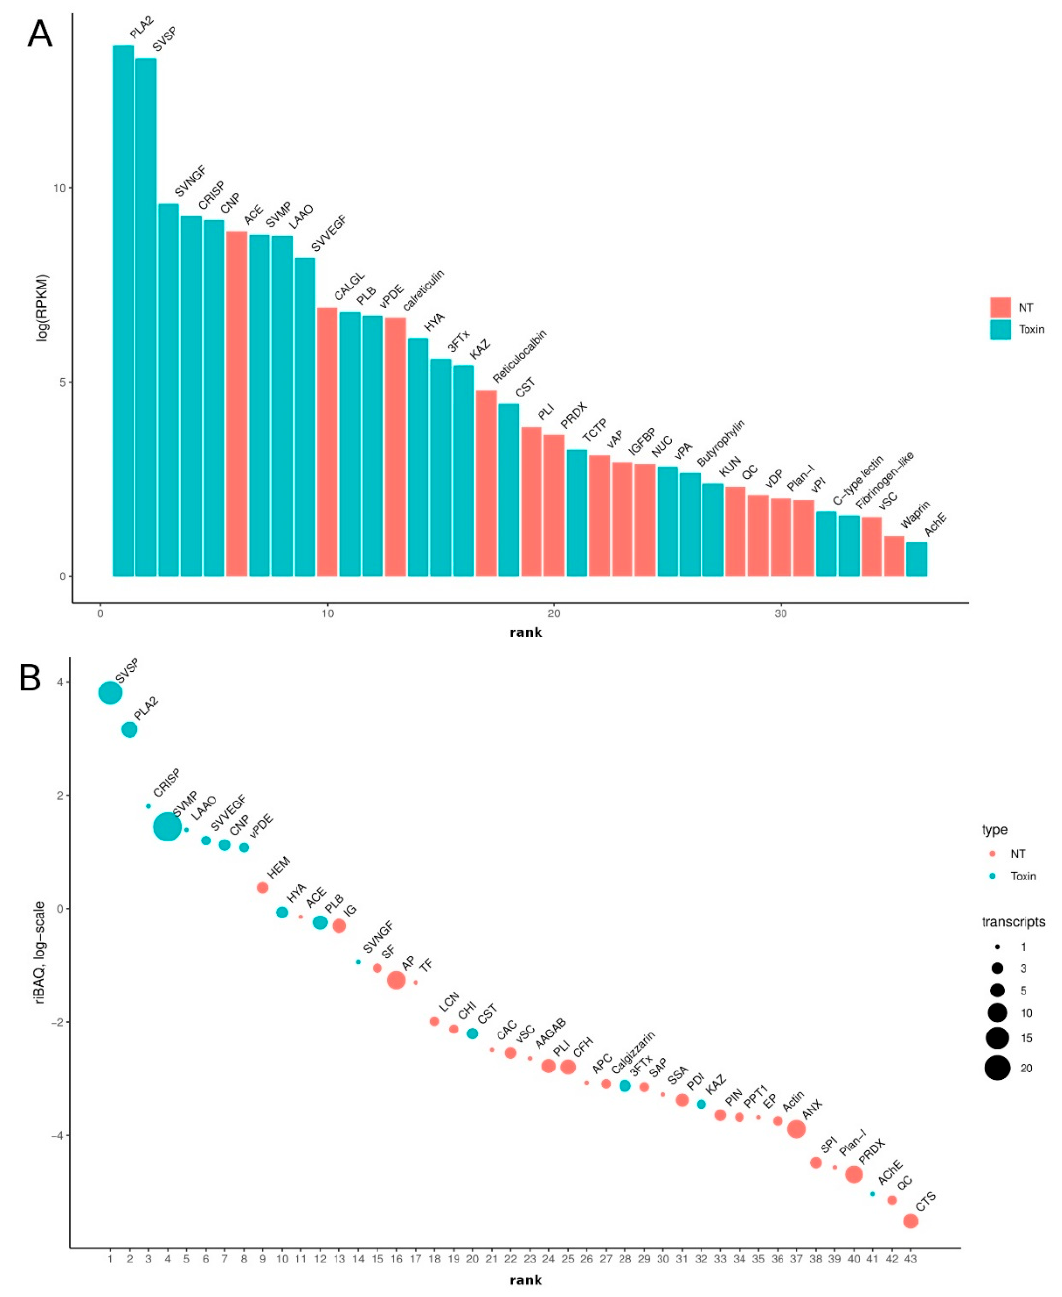
Figure 2. ( A ) Bar chart showing the distribution of Reads Per Kilobase Million (RPKM) values for all putative venom proteins (PVP) families found in transcriptome; ( B ) Scatter plot showing the distribution of riBAQ values of top 43 protein families. The diameter of the circle is proportional to the number of identified transcripts by quantitative proteomics. Abbreviations: